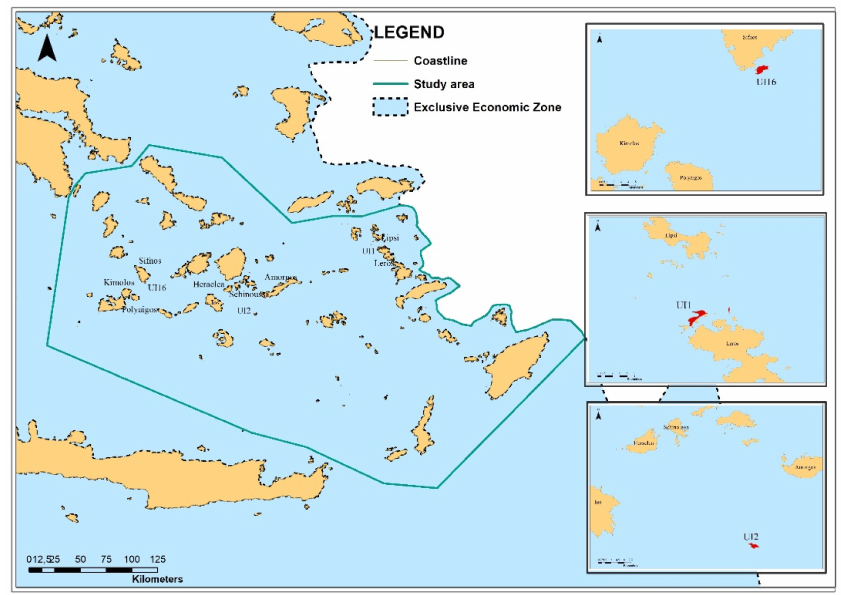
Figure 5. Eligible UIs for wind farm siting in the region of the South Aegean, Greece, after implemen- tation of all the exclusion criteria.